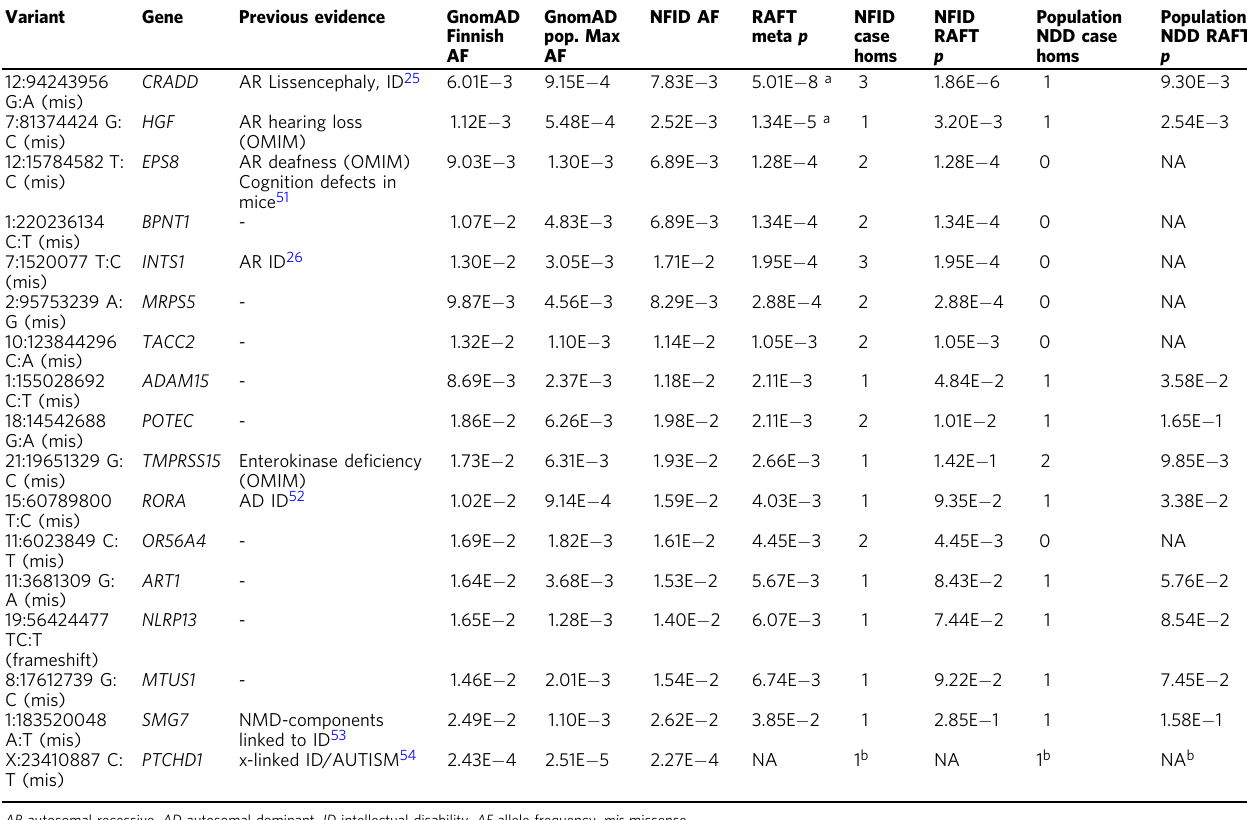
Table 3 Homozygous Finnish enriched variants observed ≥ 2 times across NFID and the Southern and Northern Finnish NDD cases and not observed in any controls as homozygous Variant Gene Previous